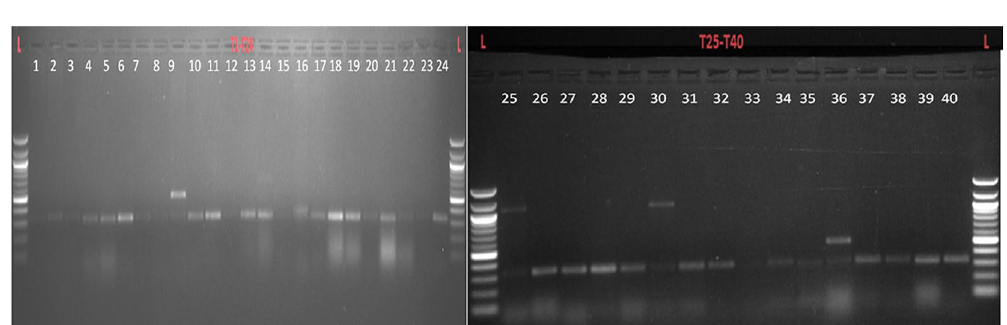
Figure 3. Amplification of DNA fragments (1–40) of selected pea lines. Amplification was possible with primer Primer PsMLO3F and PsMLO3R produced 40 amplicons of variable size (300–325 bp) in different genotypes used. L = Ladder (100